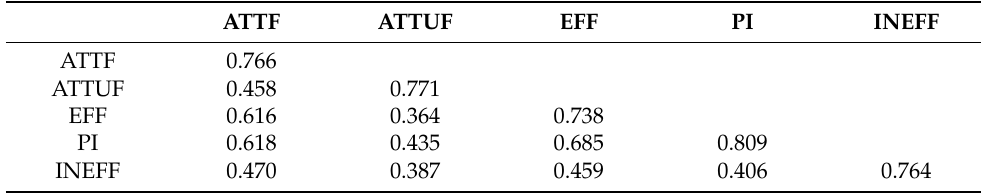
Table 4. Discriminant validity (Fornell–Larcker Table 4. discriminant validity (Fornell–Larcker criterion).